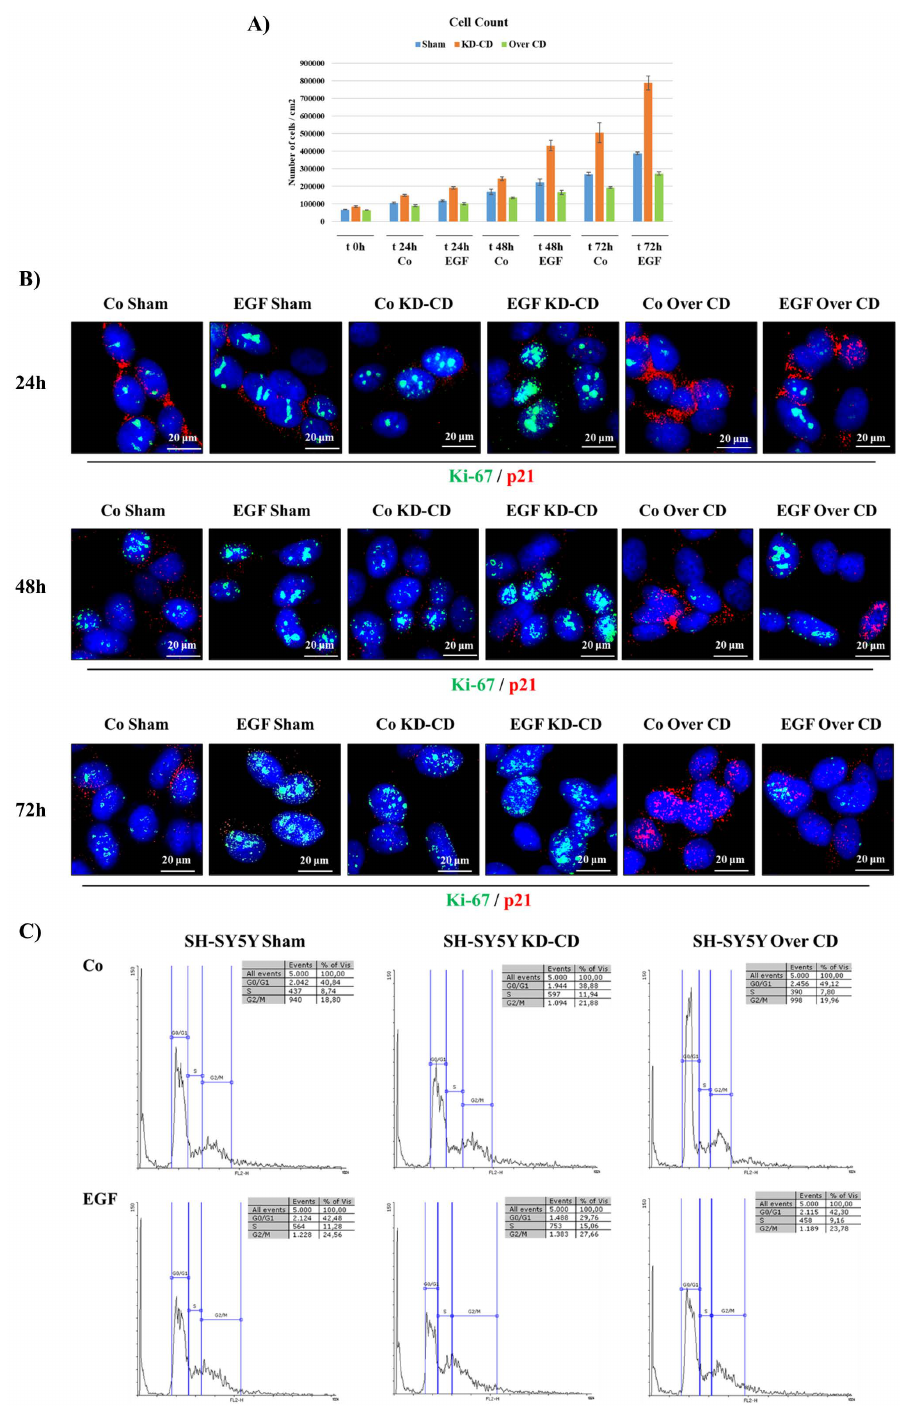
Figure 6. SH-SY5Y KD-CD cells are more sensitive to EGF and show a faster growth compared to CD-overexpressing cells. Assessment of cell proliferation following 20 ng/mL EGF treatment. ( A ) The figure shows a graphical representation of cell count, performed in triplicate for each experimental condition. The treatment was repeated every 24 h, until the end point of 72 h. Time zero is referring to the first day of treatment. ( B ) Immunofluorescence double staining at 24, 48, 72 h. Cells were stained for Ki-67 (green)/p21 (red). Scale bar = 20 µ m; magnification = 63X. Representative images of different fields for each experimental condition are shown. ( C ) Cell cycle analysis performed on SH-SY5Y clones after 72 h of EGF. The percentage of cell populations in different cell cycle phases is reported. Quantification was performed by Flowing software